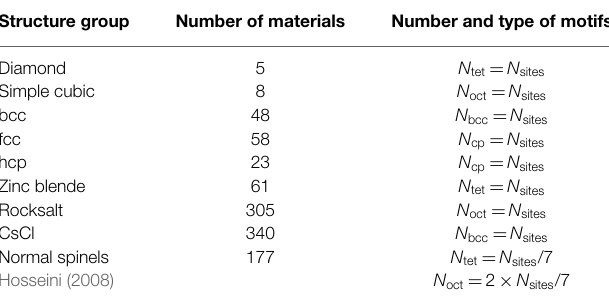
TABLE 2 | Structure groups defining the initial test